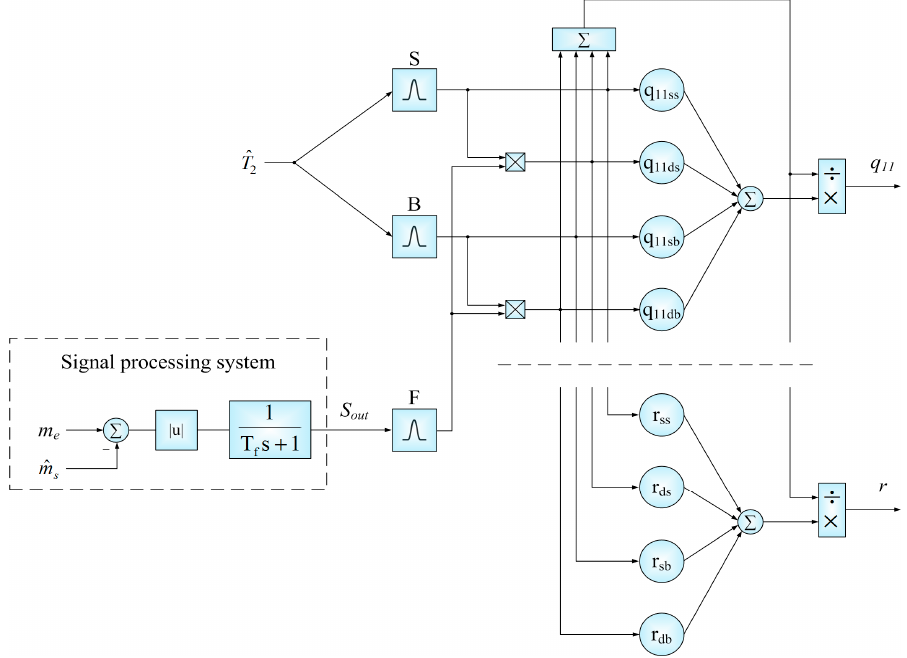
Figure 2. Structure of the fuzzy supporting system.